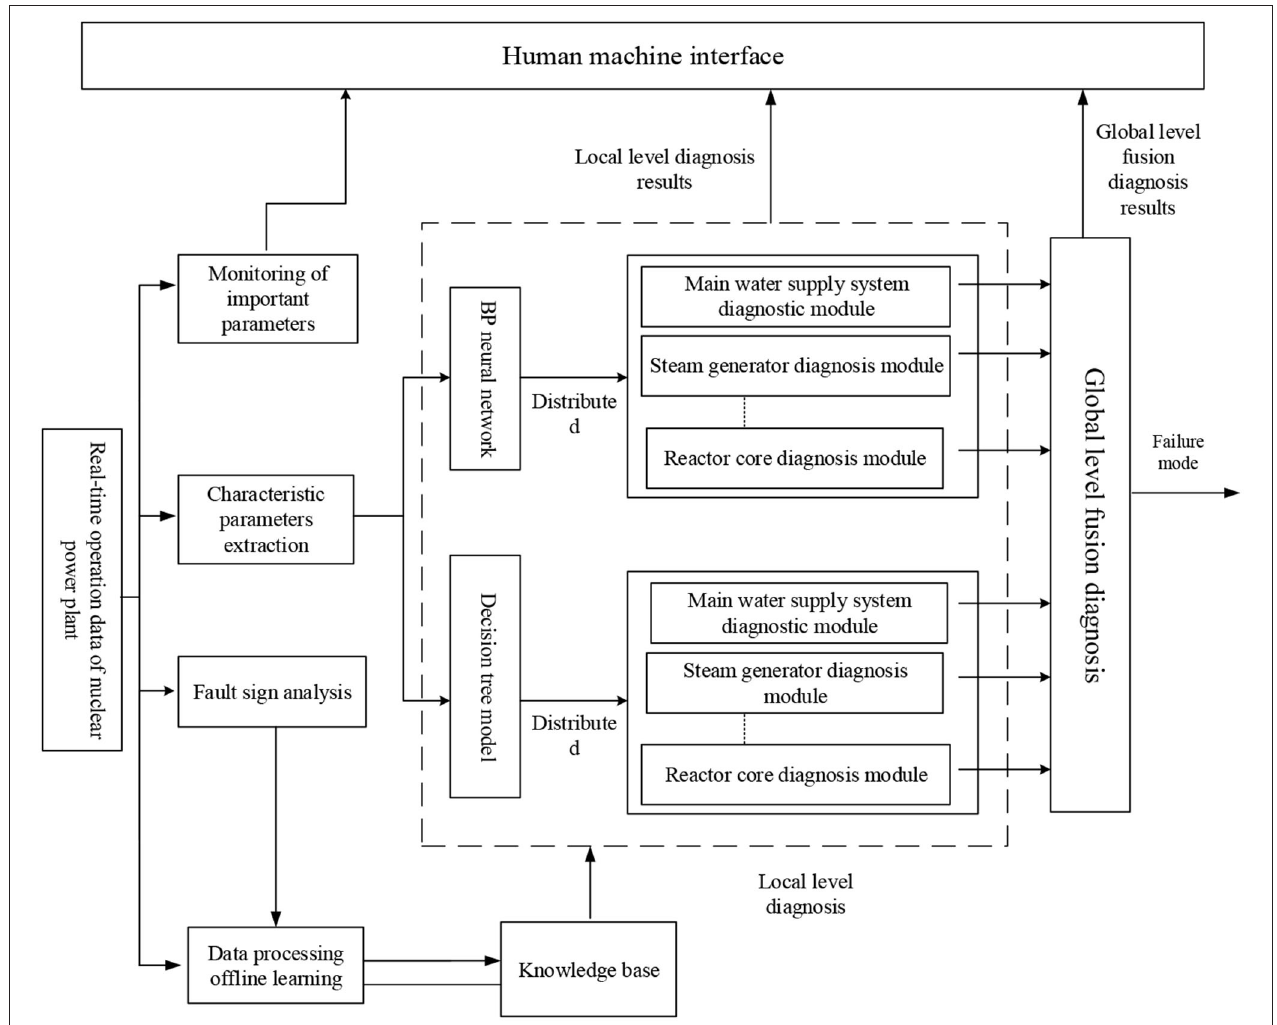
FIGURE 11 | Structure of distributed fault diagnosis system for